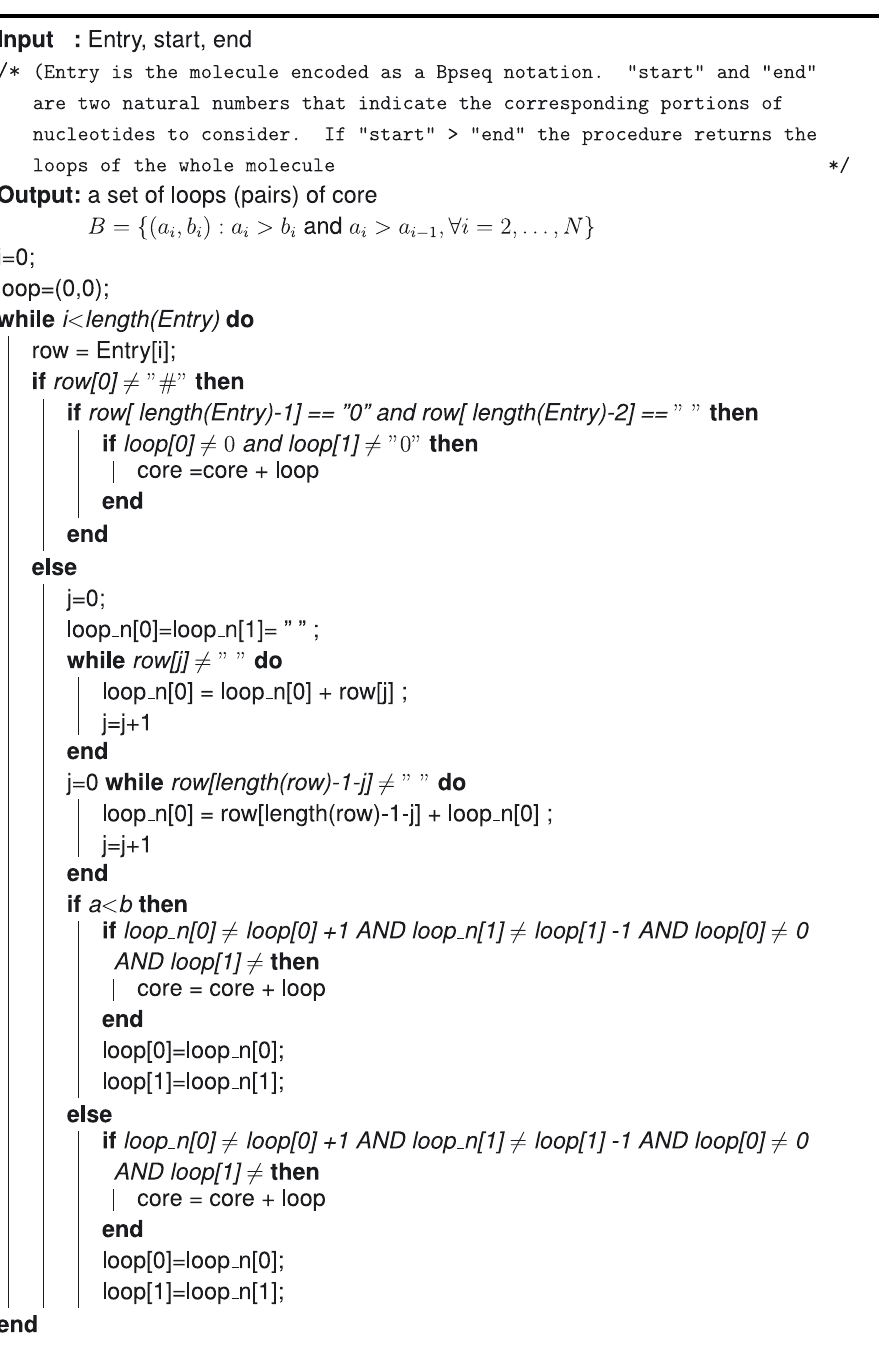
Algorithm 2: Core